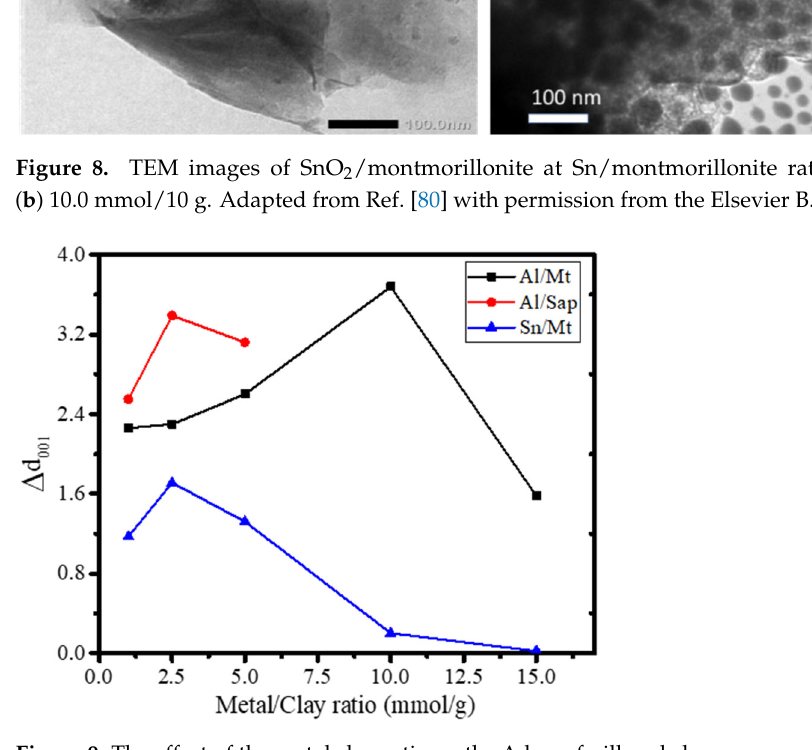
Figure 9. The effect of the metal:clay ratio on the ∆ d 001 of pillared clays.